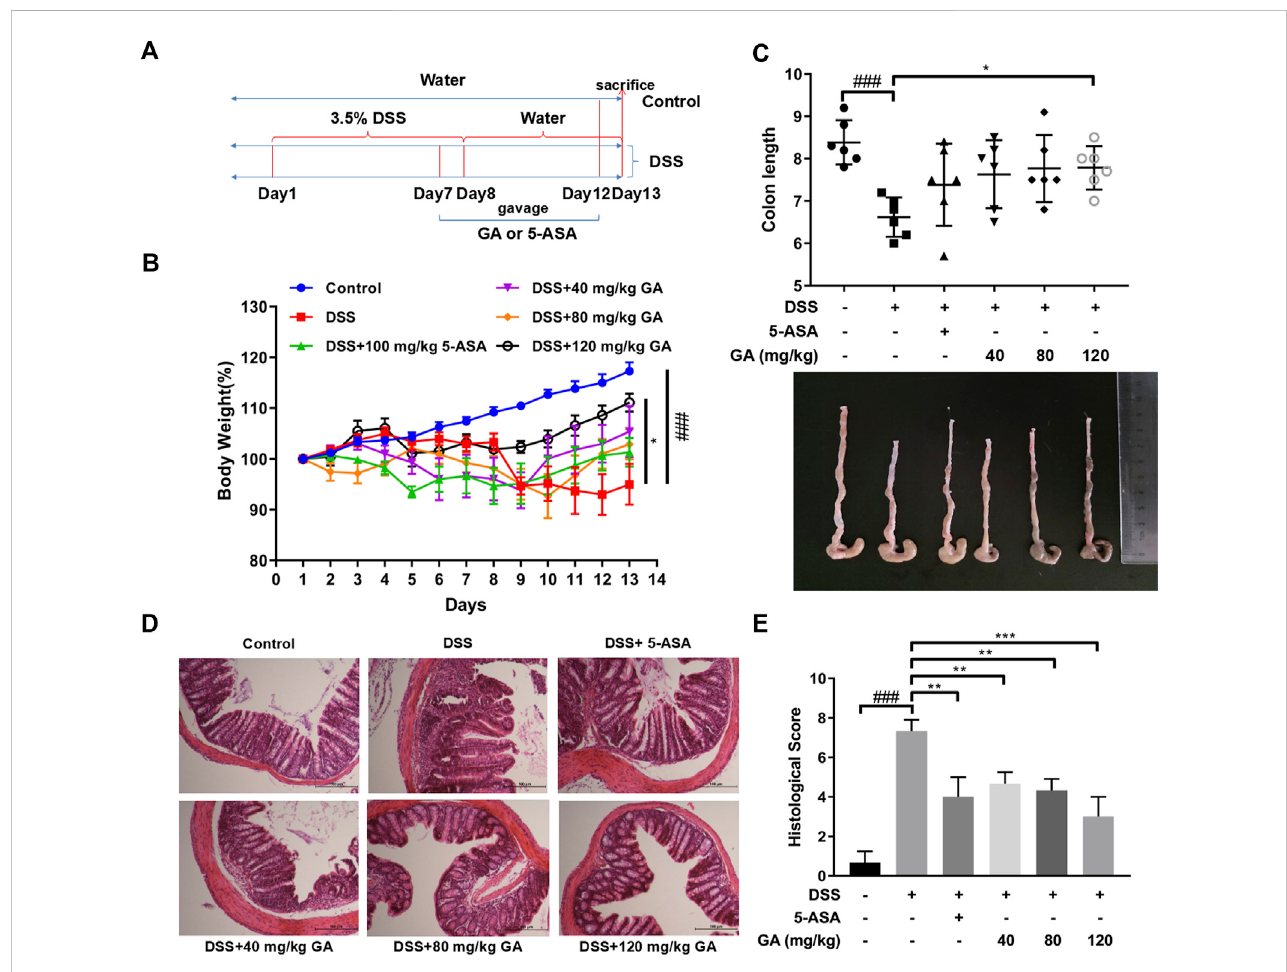
FIGURE 1 GA attenuated DSS-induced murine colitis. BALB/C mice were orally administrated with GA 40 mg/kg, 80 mg/kg, and 120 mg/kg once daily from day 7to day12. 5-ASA was orallyadministrated with 100 mg/kgfor the positive Control group. (A) Experiment design. (B) Body weights were measured daily from day 1 to day 13 and performed as a ratio to that at day 1. (C) Colon length. (D) Colon sections (100×) were examined using HE staining. (E) Histological score. Data are presented as mean ± SD (n = 6); ### p < 0.001 vs. Control group by t -test; * p < 0.05, ** p < 0.01, and *** p < 0.001 vs. DSS